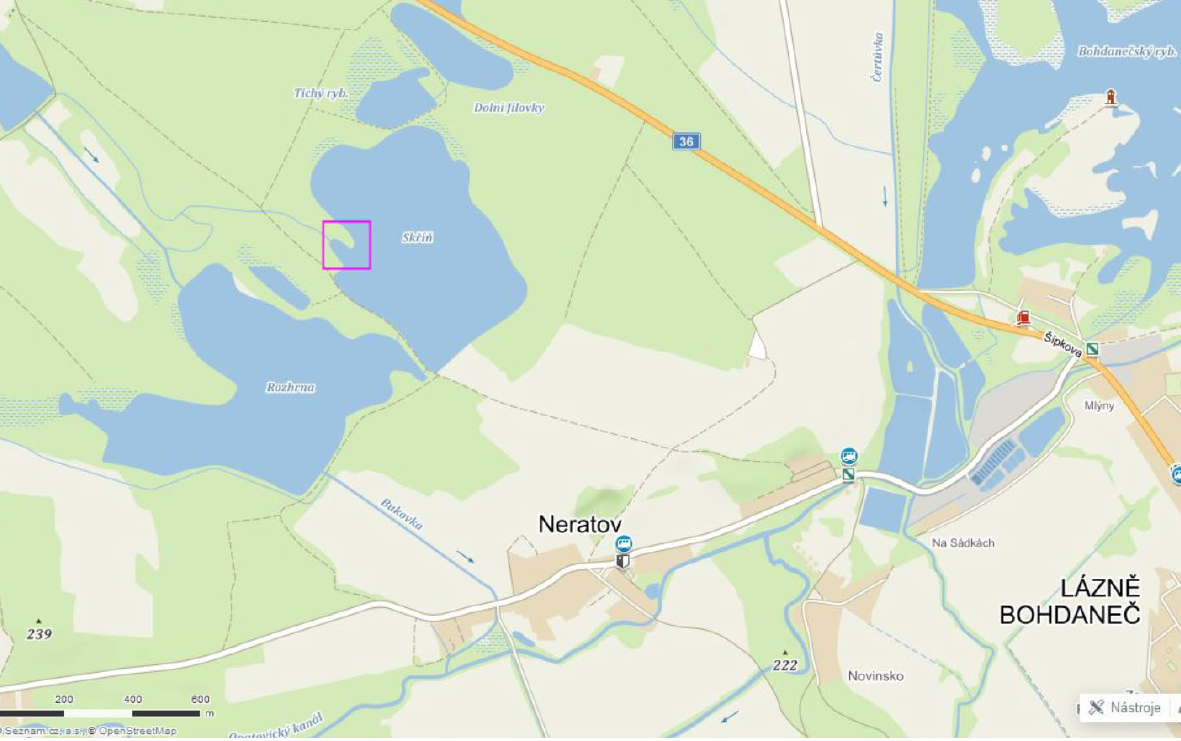
Figure 1. Area of interest (source: mapy.cz)